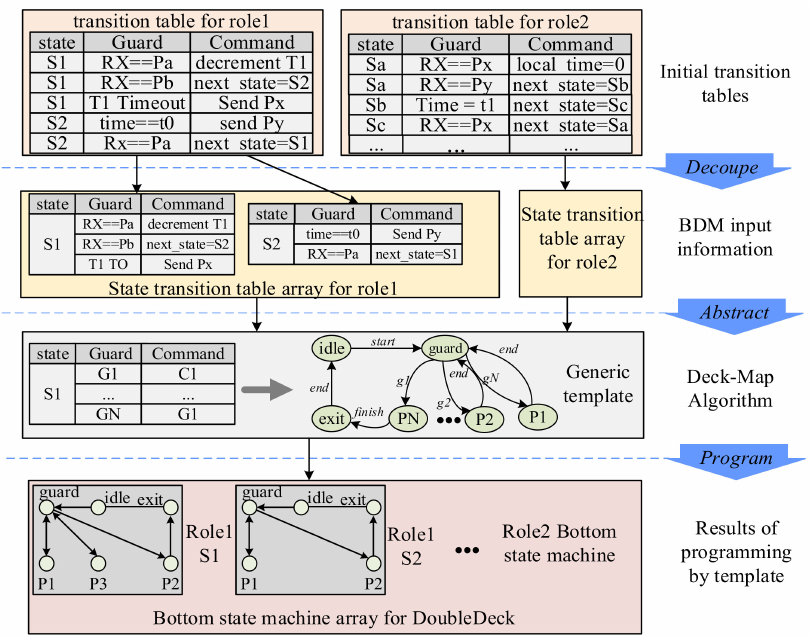
Figure 4. The overview of bottom deck mapping